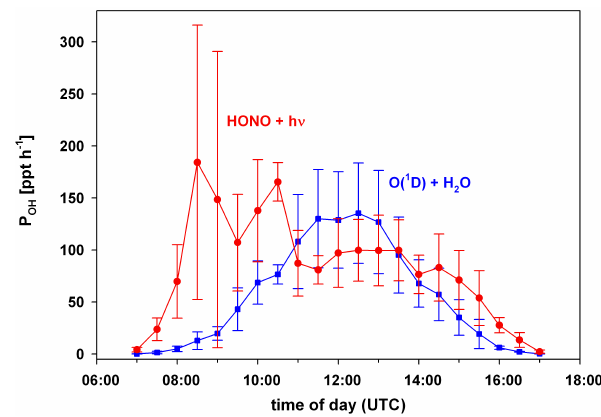
Fig. 7. Comparison for the seven clear days of the campaign of calculated primary OH production by HONO and ozone photolysis (means and standard